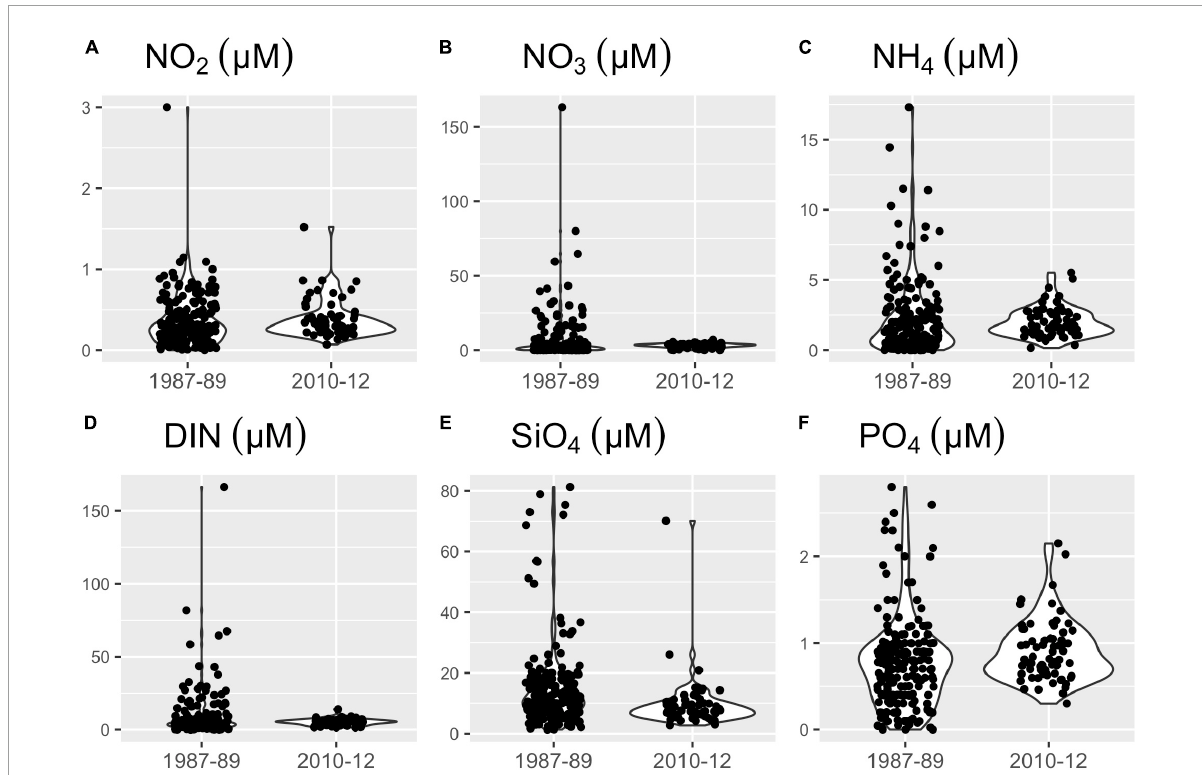
FIGURE3 Violin plots of nutrient concentrations in micromolar ( µ M) comparing the two subsets of data: 1987–1989 prior to the interventions, and 2010–2012 after the latest UWWT plant upgrade. (A) Nitrite (NO 2 ); (B) Nitrate (NO 3 ); (C) Ammonia (NH 4 ); (D) Dissolved Inorganic Nitrogen (DIN); (E) Silicate (SiO 4 ); (F) Orthophosphate (PO 4 ) from Ramalhete and Ponte in the western lagoon. Raw data are shown as black